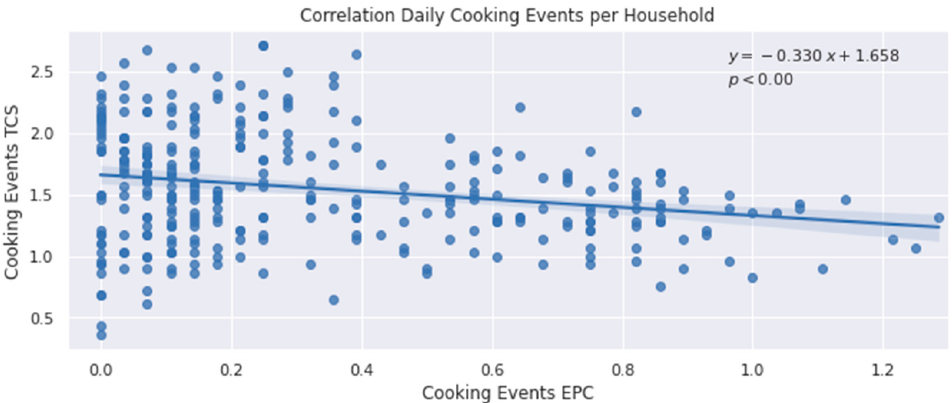
Figure 11. Time series of TCS and EPC events per day (averaged across 28 households).